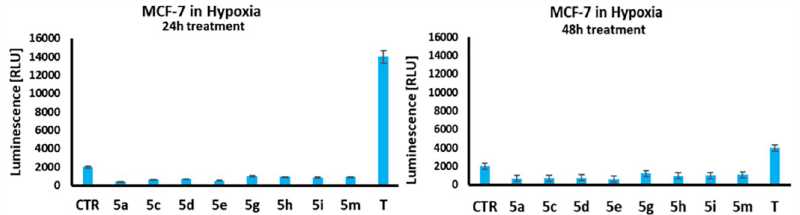
Fig 5. Exposure of selected fuberidazole derivatives to MCF-7 at hypoxia after 24 and 48 h. At the indicated concentrations, cells were cultured in the absence/ presence (CTR, control) of the selected compounds and tirapazamine (T) as a control substance. Caspase 3/7 activity was determined after 24 and 48 h of therapy. The caspase’s activity was quantified by using a luminescence light unit [RLU] and represented as a mean ± S.D., n = 3, � p <